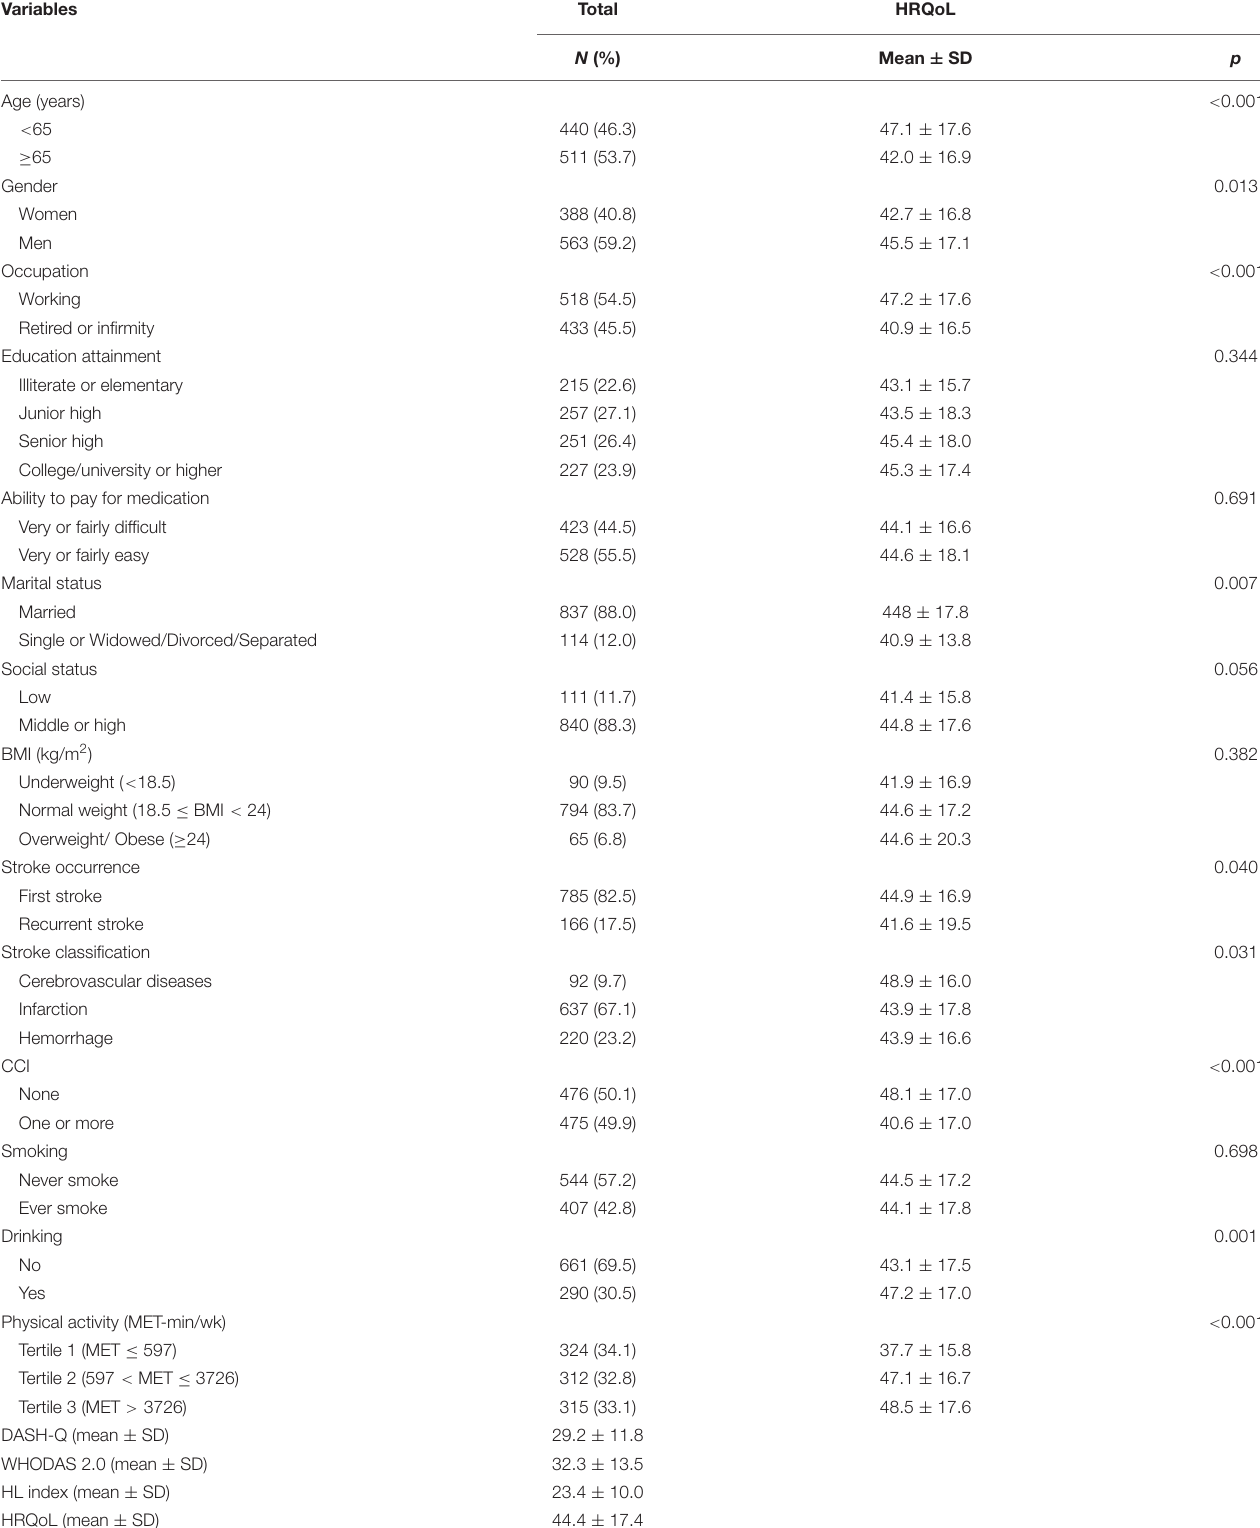
TABLE 1 | Characteristics and health-related quality of life (HRQoL) in patients with stroke ( n =